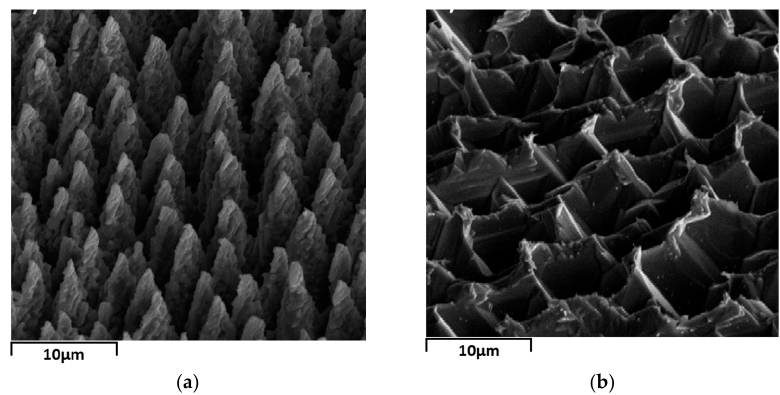
Figure 1. SEM micrographs (viewed at 45°) of laser-textured silicon surface ( a ) before and ( b ) after alkaline etching.